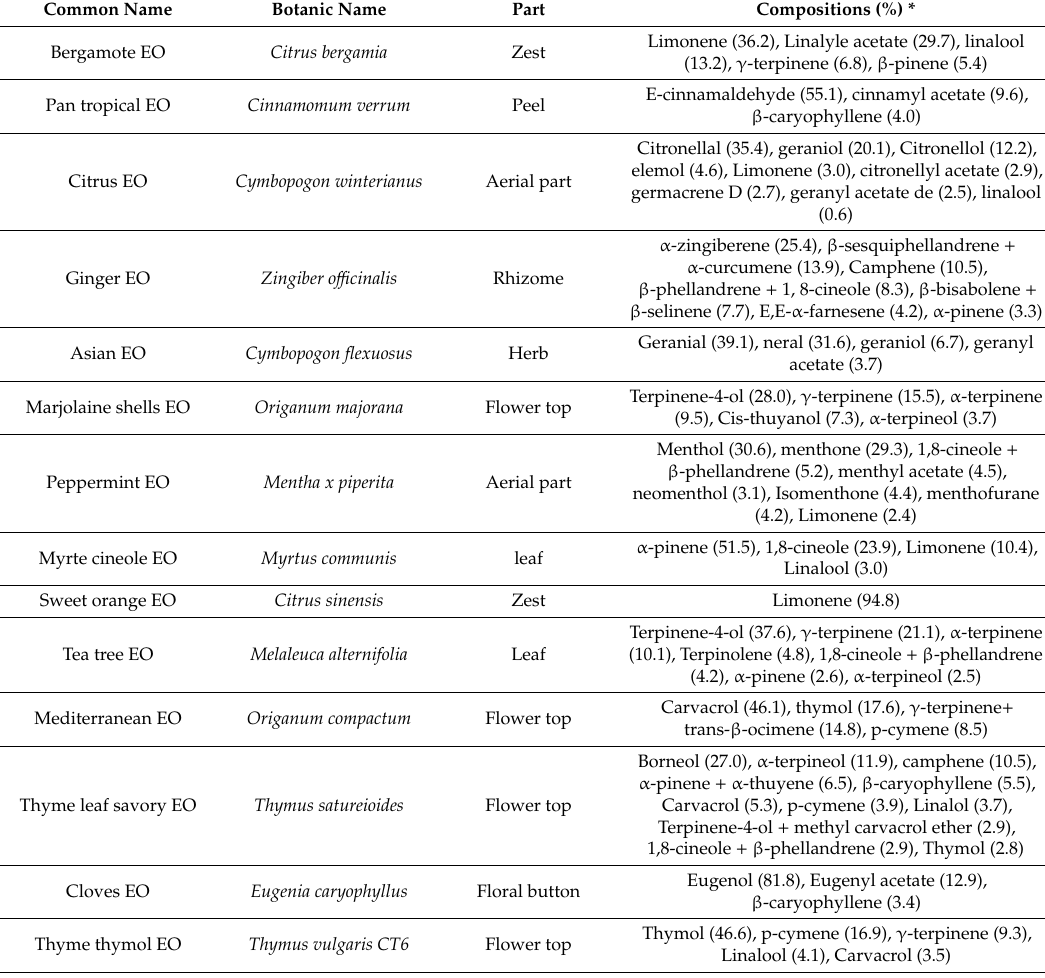
Table 1. Biosecur F440D, citral and essential oils were stored at 4 Table 1. List of organic essential oils (EO) and their